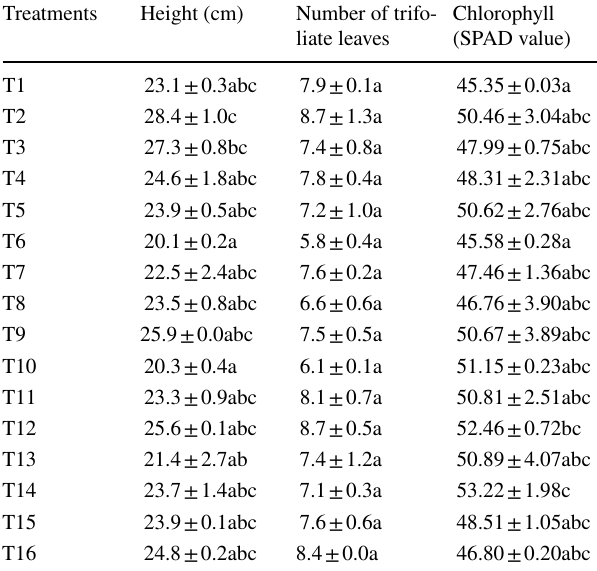
Table 6 Mean values ± standard errors for plant height, number of tri- foliate leaves, and SPAD value of mung bean at 50 DAS